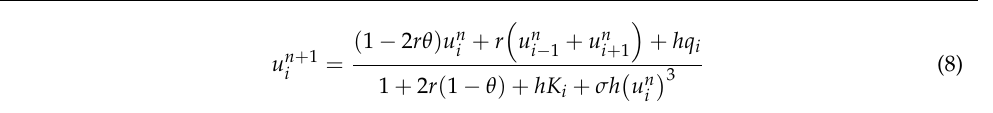
Algorithm 3: Theta-generalization of Algorithm 2